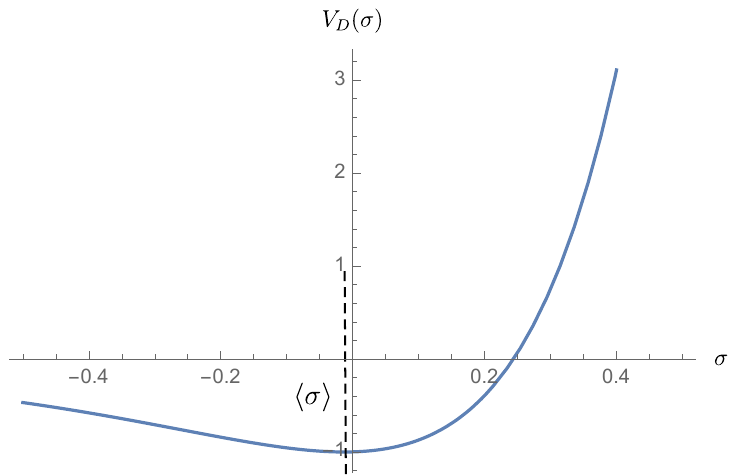
Figure 2 . The dilaton potential in arbitrary units. The dilaton gets a vev away from the origin once the Higgs develops the electroweak